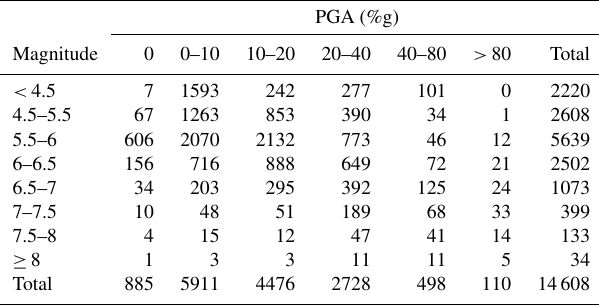
Table C1. Number of ShakeMaps in the dataset by magnitude and maximum PGA level. The magnitude distribution of earthquakes with magnitude above 5.5 follows a power law, as expected for a comprehensive sample of earthquakes. For lower-magnitude events ShakeMaps are not consistently produced and a less consistent mag- nitude distribution is therefore observed in that